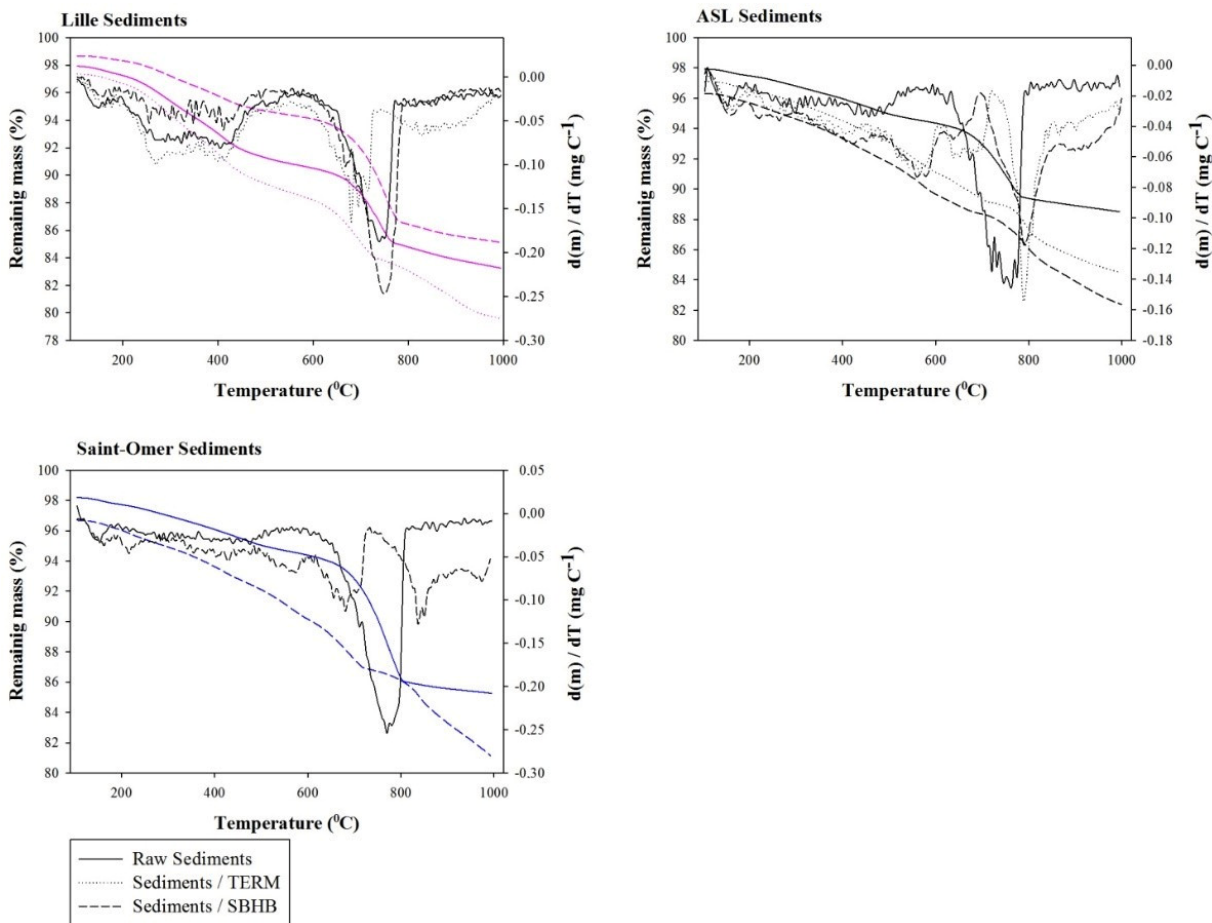
Figure 2. Thermal evolution (TGA) of the three sediments (Lille, Saint-Omer and ASL) before and after stabilization with the Thermo-Evolved Red Mud (TERM) and the Slag Based Hydraulic Binder (SBHB). Δ *: Mass variations within the raw sediment.